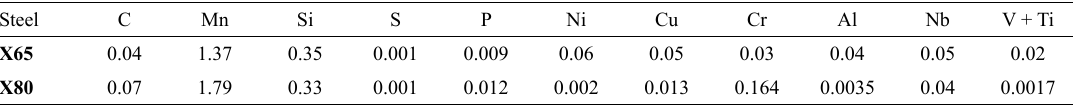
Table 2. Chemical composition of the API 5L X65 and X80 steel